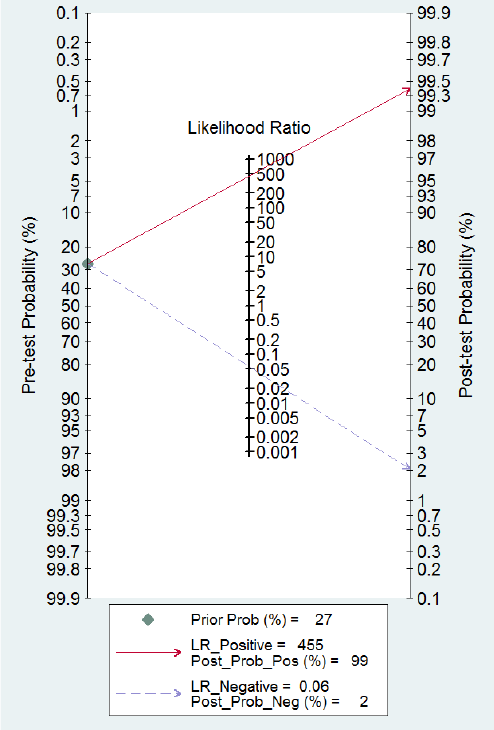
Figure 6. Fagan nomogram for two-dimensional transvaginal ultrasonography. It can be observed how the test changes the pre-test probability depending on a positive or negative result.